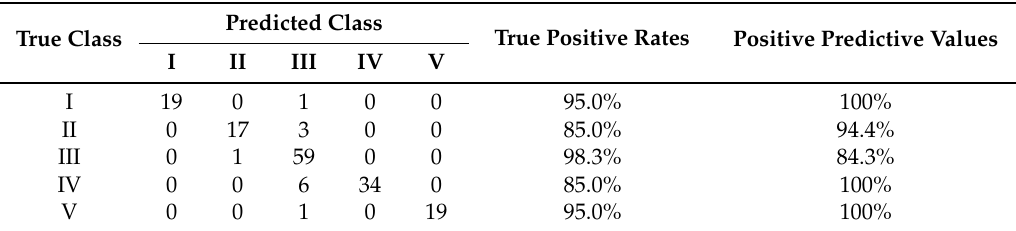
Table 1. Confusion matrix for the support vector machine.